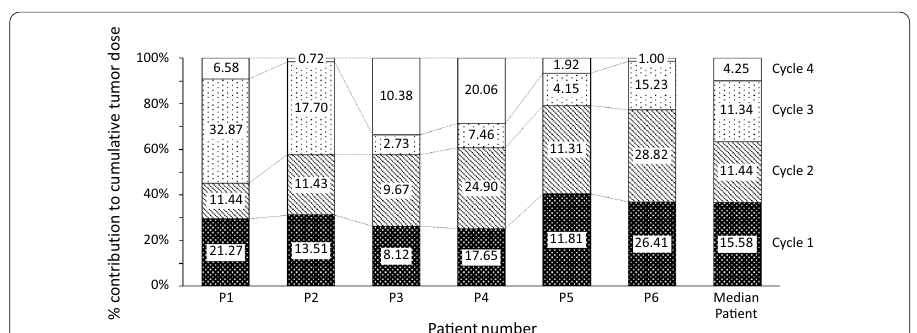
Fig. 2 The contribution to the cumulative absorbed dose to the tumour from each cycle of therapy for each of the six patients (P1-P6), with the median values shown in the last bar. The numbers in the bars represent the absolute values of the tumour absorbed dose in Gy